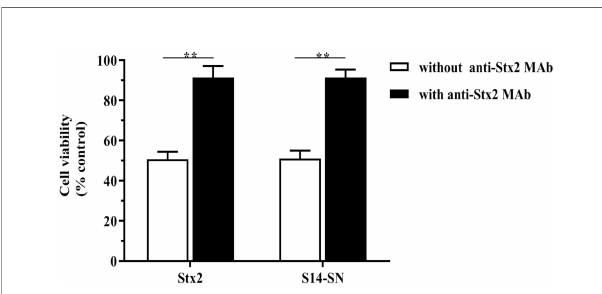
FIGURE 2 | Neutralization of the Stx2 cytotoxicity of bacterial supernatants isolated from endocervical samples on the viability of Vero cells. The bacterial supernatant from the endocervical sample 14 (S14-SN, dilution 1:5000) was preincubated with the mouse monoclonal antibody 2E11 against the A- subunit of Stx2 (anti-Stx2 mAb, 25 µg/mL) at 37°C for 1 h. The mixture was then added to a 96-well culture plate containing Vero cells and incubated for 72 h. The CD 50 of puri fi ed Stx2 (1 ng/mL) incubated with anti-Stx2 mAb was used as control. Cell viability was analyzed by neutral red uptake. Data are shown as mean ± S.D from at least three independent experiments performed in triplicate. ** p < 0.01,